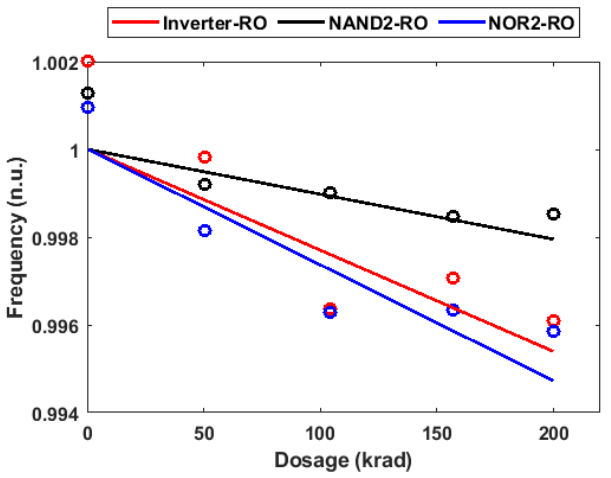
Figure 8. RO frequencies vs. total absorbed dose during heavy ion test.